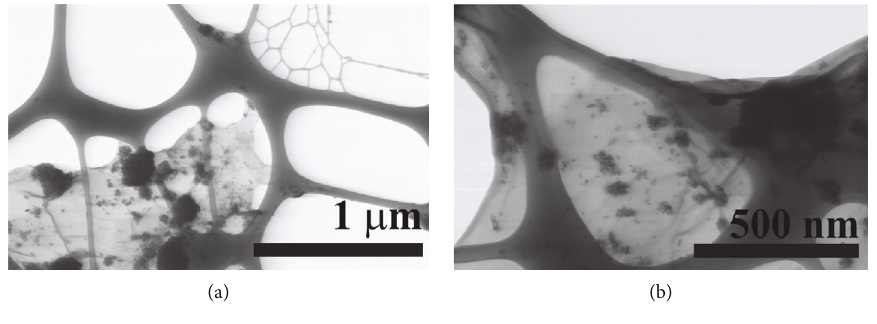
Figure 3: STEM bright- fi eld